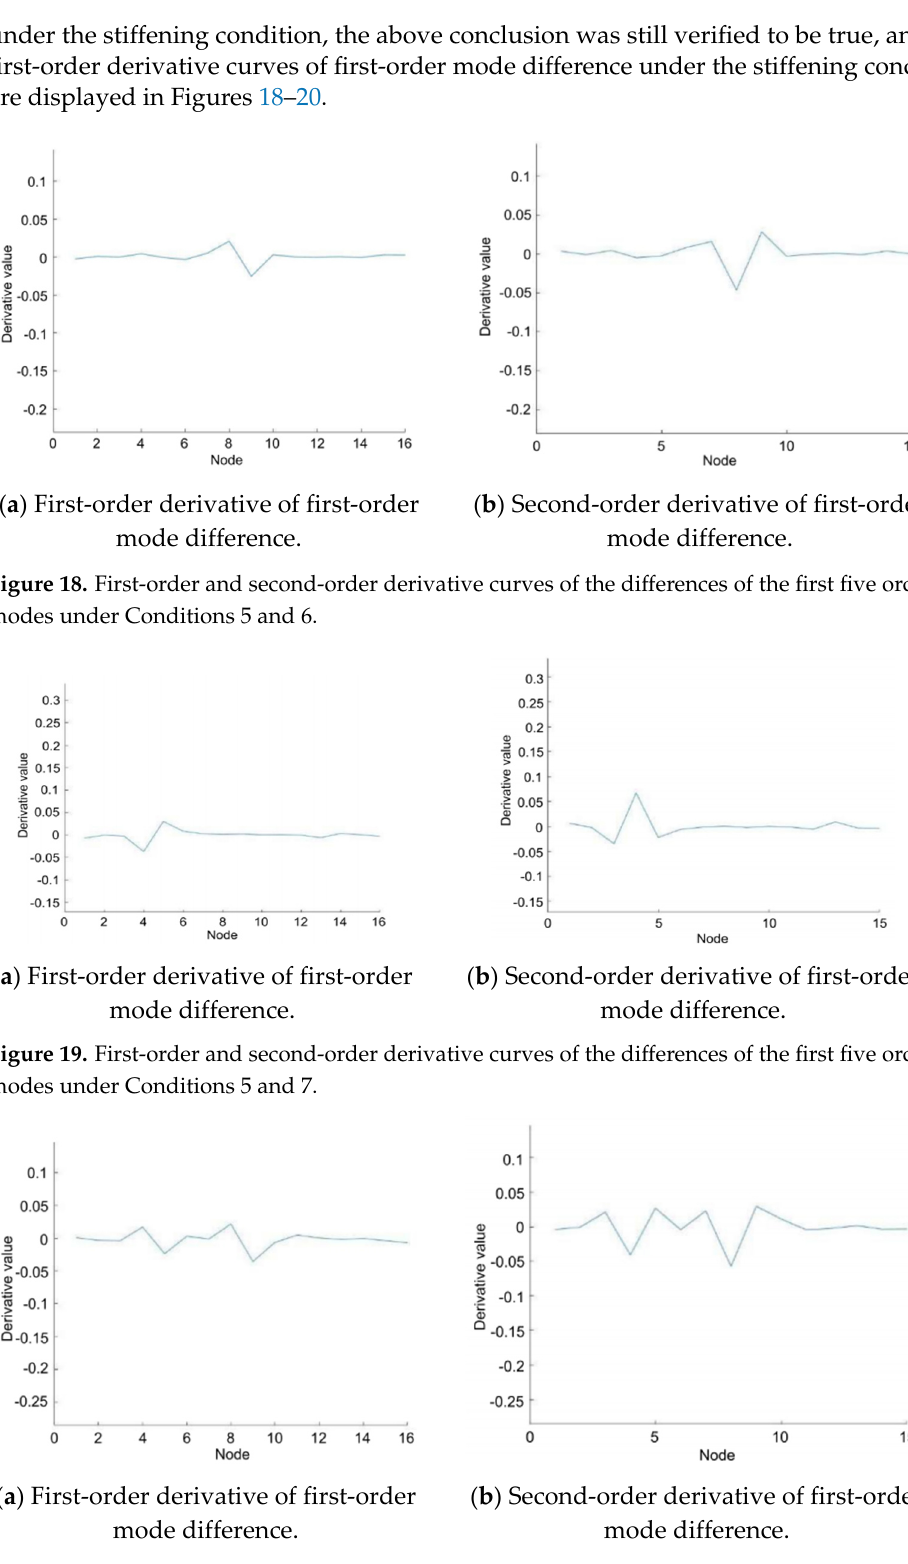
Figure 20. First-order and second-order derivatives of the differences of the first five orders of modes under Conditions 5 and 8.